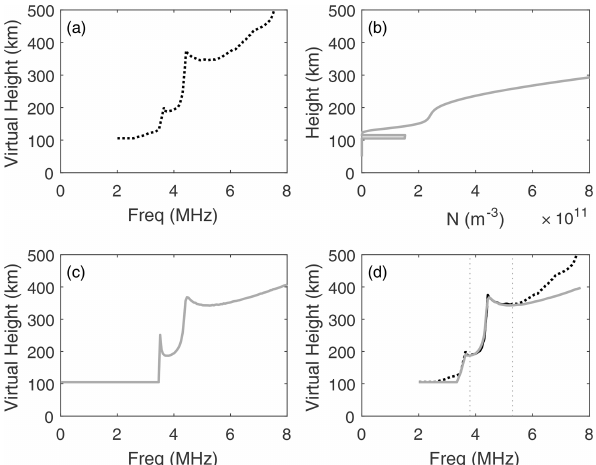
Figure 2. An example of the fitting procedure. The virtual height profile is manually scaled from an ionogram (a) . The five fit pa- rameters are then iterated to create an electron concentration pro- file (b) which is in turn inverted to create an artificial ionogram (c) . The values of the variables are iterated until the residual is min- imised between the real and model ionograms (d) . The comparison between the model ionogram (grey) and the real ionogram is only valid in the transition region (indicated by the two vertical dotted lines), and so only the data between these lines are considered when calculating the minimum